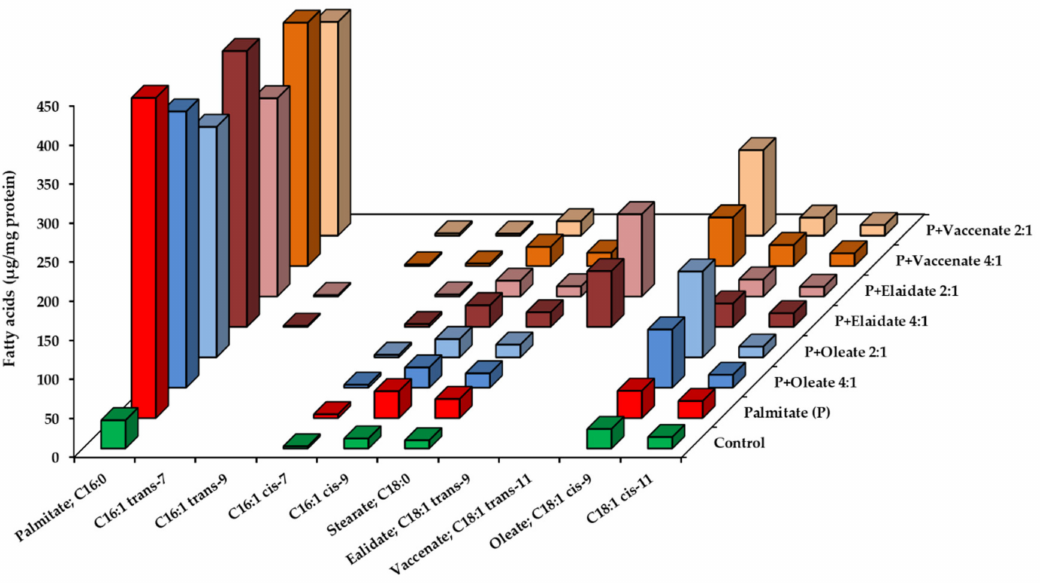
Figure 4. Fatty acid profile of HepG2 cells supplemented with high concentration palmitate and a monounsaturated fatty acid. Cells were treated with BSA-conjugated palmitate (800 µ M) and oleate, elaidate or vaccenate at a 4:1 or 2:1 molar ratio (200 or 400 µ M) at 70–80% confluence for 8 h. The amount of relevant fatty acids was measured by GC-FID after saponification and methylation. Data were normalized to the total protein content of the samples and are shown as mean values of at least four independent experiments (see the mean and S.D. values in Table S5).